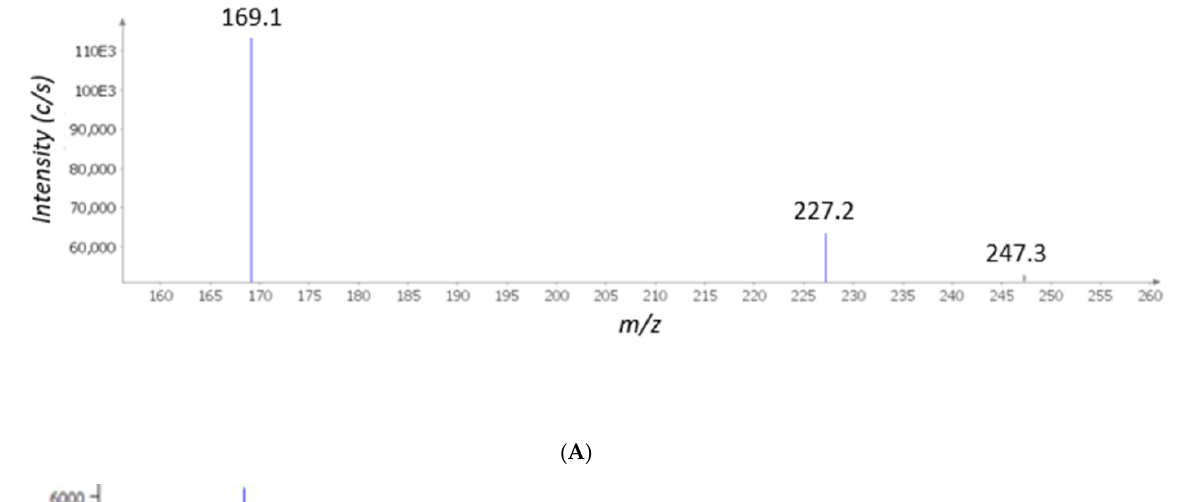
Figure 1. ( A ) The qualitative mass spectrometry (MS) analysis conducted on the Tanacetum parthenium water extract. The MS analysis of gallic acid, resveratrol, and parthenolide was conducted in negative ion mode ( m / z scan mode: 119–556), and the m/z ratios of 169.1, 227.2, and 247.3 were monitored to identify gallic acid, resveratrol, and parthenolide, respectively. ( B ) The qualitative the high performance liquid chromatography coupled to diode-array detection (HPLC-DAD) analysis showing the presence of catechin (1), chlorogenic acid (2), and rutin (4) in the T. parthenium extract. The chromatographic analysis also showed the presence of unidentified phenolic compounds (3, 5, 6).